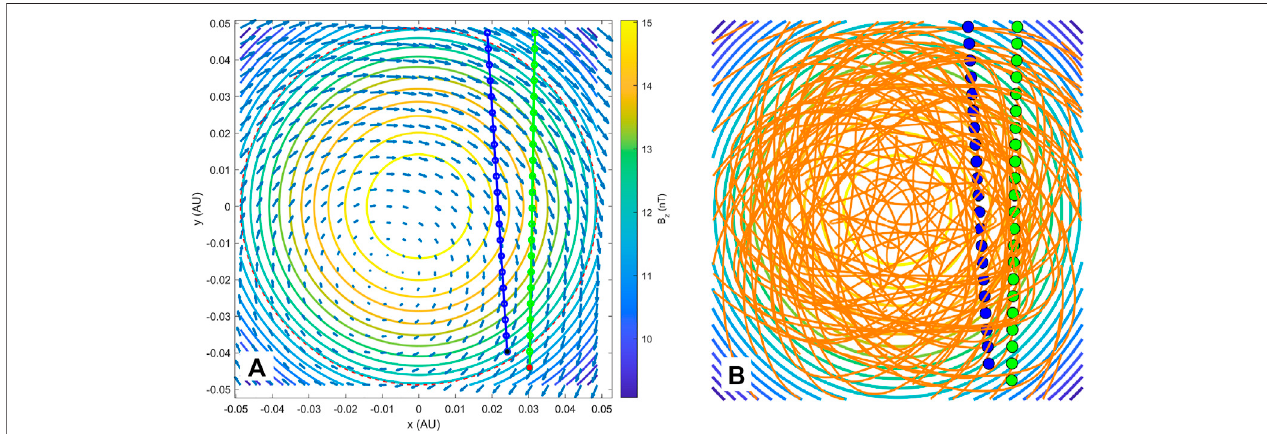
FIGURE 7 | (A) One cross section of the optimal Freidberg solution where the colored contours represent B z distribution and arrows represent the transverse fi eld components. The Wind and SO spacecraft paths are shown by the blue and green lines with dots, respectively. (B) The same view and contour lines for B z as (A) . The orange lines are the fi eld lines originating from the cross section plane, and viewed down the z axis.